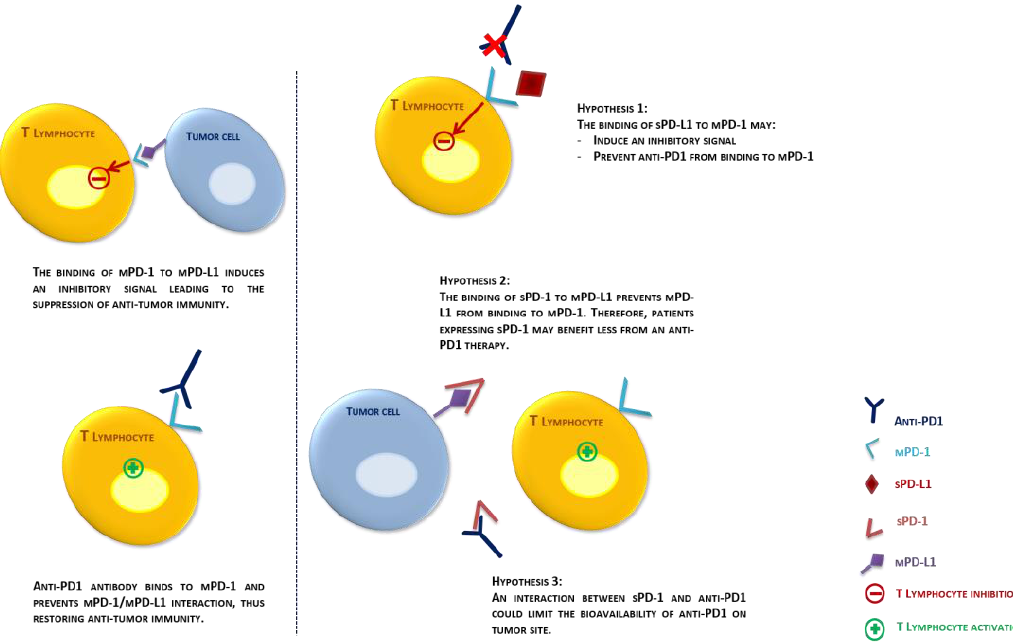
Figure 4. Three theoretical interaction between sPD-1, sPD-L1 and the tumour and its environment, leading to resistance to anti-PD1 therapies. sPD-1 / sPD-L1: soluble PD-1 / PD-L1; mPD-1 / mPD-L1: membrane-bound PD-1 / PD-L1.